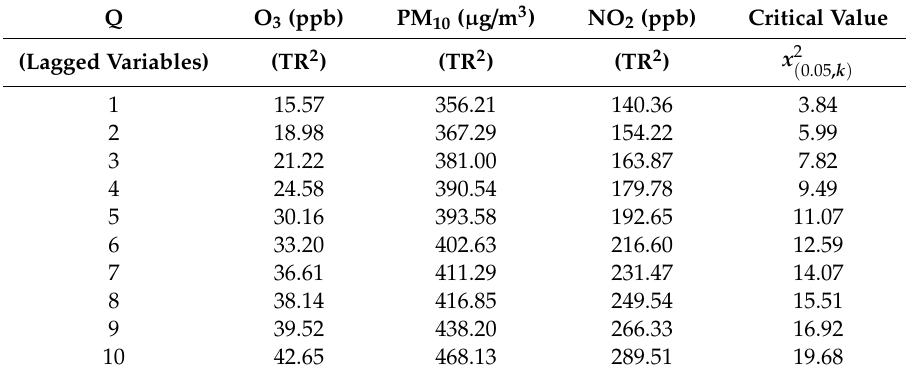
Table 2. Results of Autoregressive Conditional Heteroscedasticity (ARCH) e ff ectiveness for 3 air